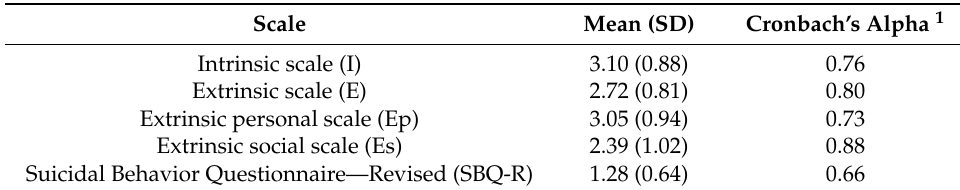
Table 1. Descriptive Statistics and Cronbach’s Alphas for the